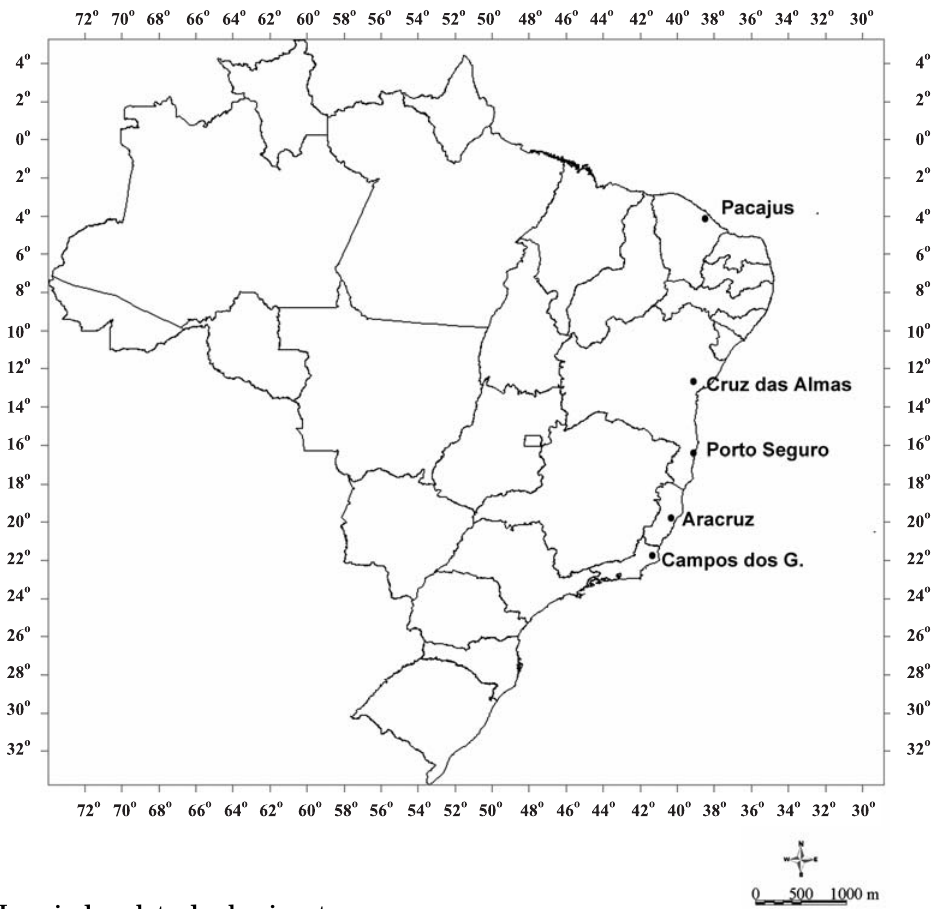
Figura 1. Locais de coleta dos horizontes